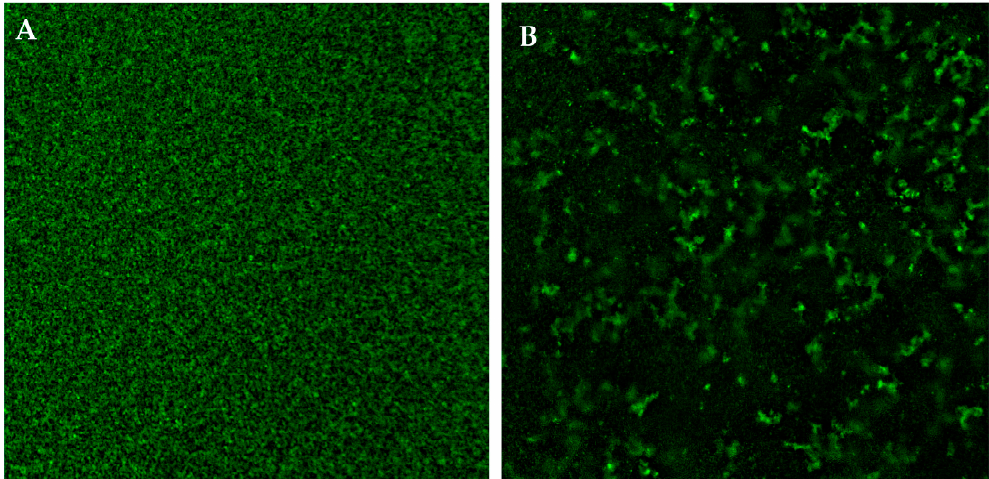
Figure 5. Effect of PLA on biofilm morphology. C. albicans 90028 biofilm formed for 48 h in the absence of PLA ( A ) and treated with 2.5 mg mL 1-PLA ( B ). The morphology of biofilms was visualized using a Zeiss LSM700 confocal microscope at 10X magnification.